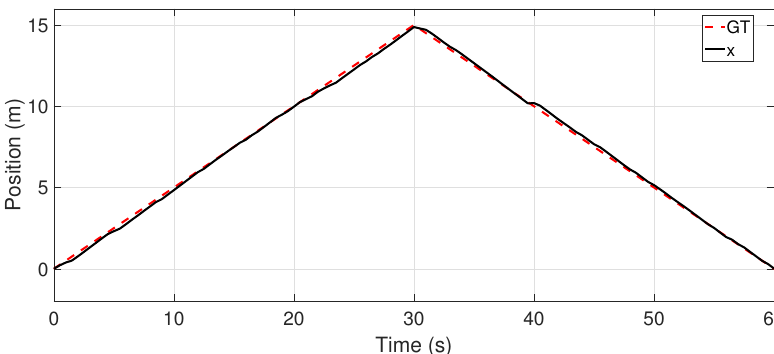
Figure 7. x -axis coordinate tracking for test 1.